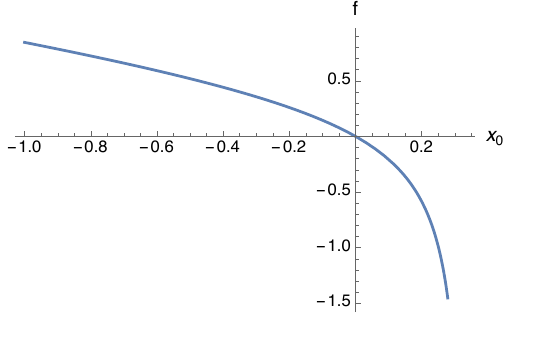
Figure 4 . Function f ( x 0